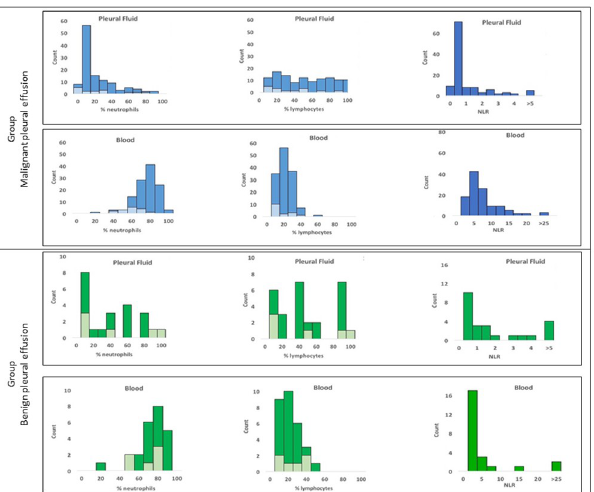
Fig 2. Frequency distribution of samples by % neutrophils, % lymphocytes and Neutrophil to Lymphocyte Ratio (NLR) in malignant pleural effusions (left panel) and blood (right panel). Results from patients with malignant pleural effusions (MPE) are in blue and benign effusions in green. Samples with concurrent infection are shown in lighter colour for neutrophil and lymphocyte distribution.